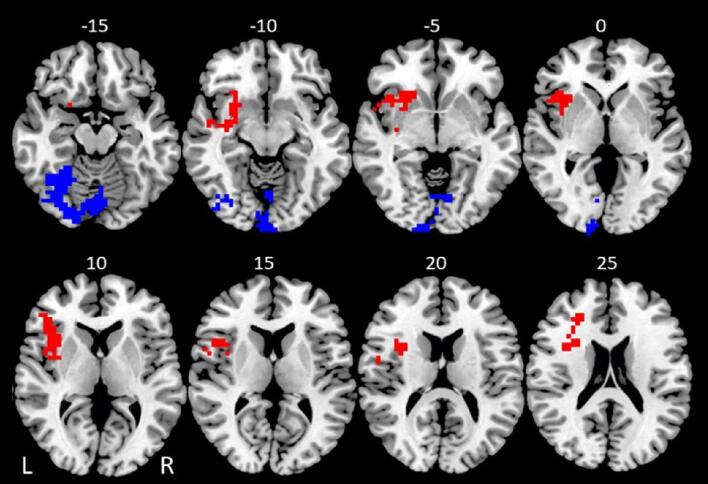
Axial slices showing linear correlations across all subjects between fMRI-NF regulation learning scores and brain activation during successful stop–go trials during the baseline stop task at false positive error-corrected voxel-level of p < 0.05, and cluster-level of p < 0.005 (yielding < 1 false positive cluster per map). The brain cluster in red corresponds to the significant positive correlation between brain activation and fMRI-NF learning scores, and the brain cluster in blue corresponds to the significant negative correlation between activation and fMRI-NF learning scores. The right side of the image corresponds to the right side of the brain. Axial slices are shown in mm distance from the anterior-posterior-commissure. (For interpretation of the references to colour in this figure legend, the reader is referred to the web version of this article.)